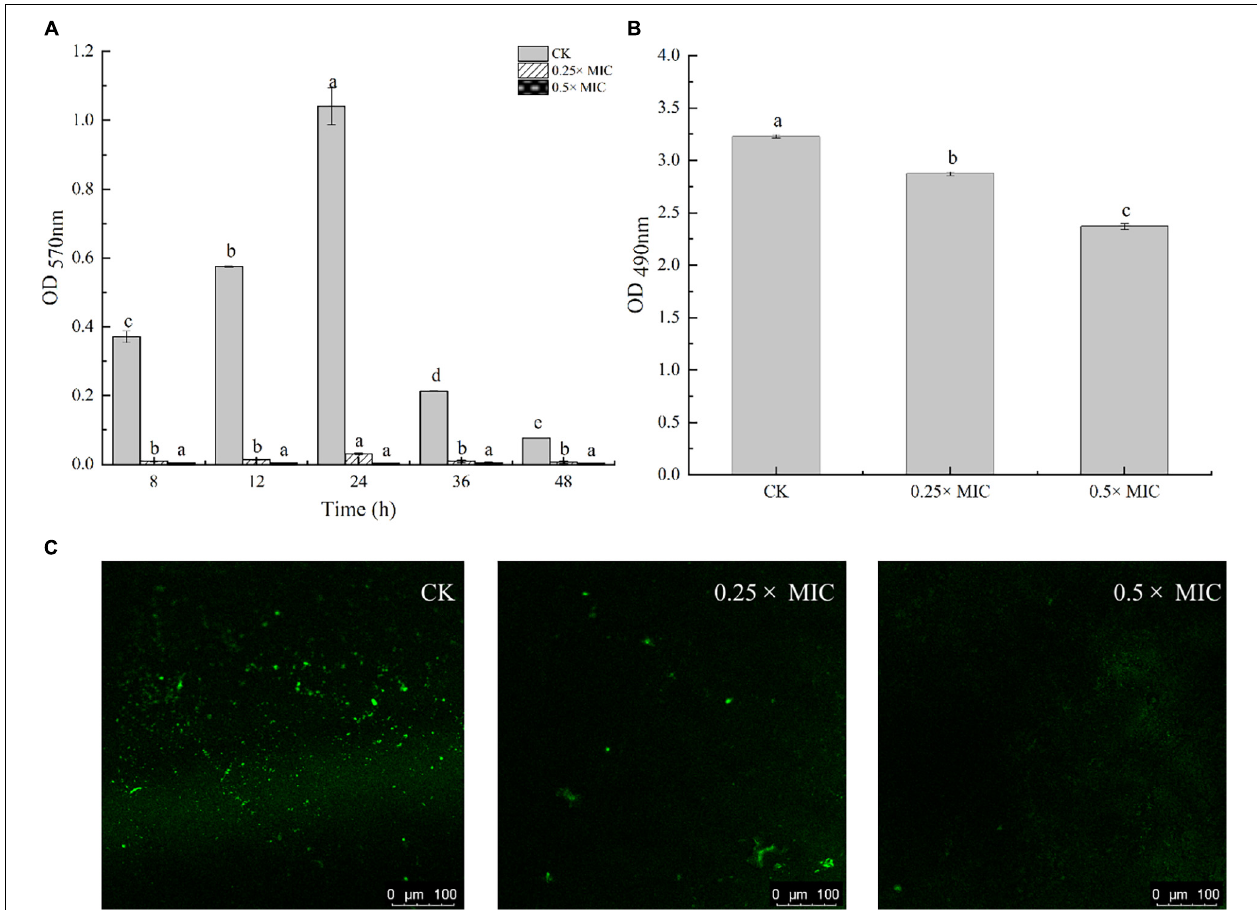
FIGURE 4 | Effect of Melissa officinalis L. essential oil on biofilm formation (A) , EPS production (B) , and CLSM (C) . CK is the V. parahaemolyticus without Melissa officinalis L. essential oil